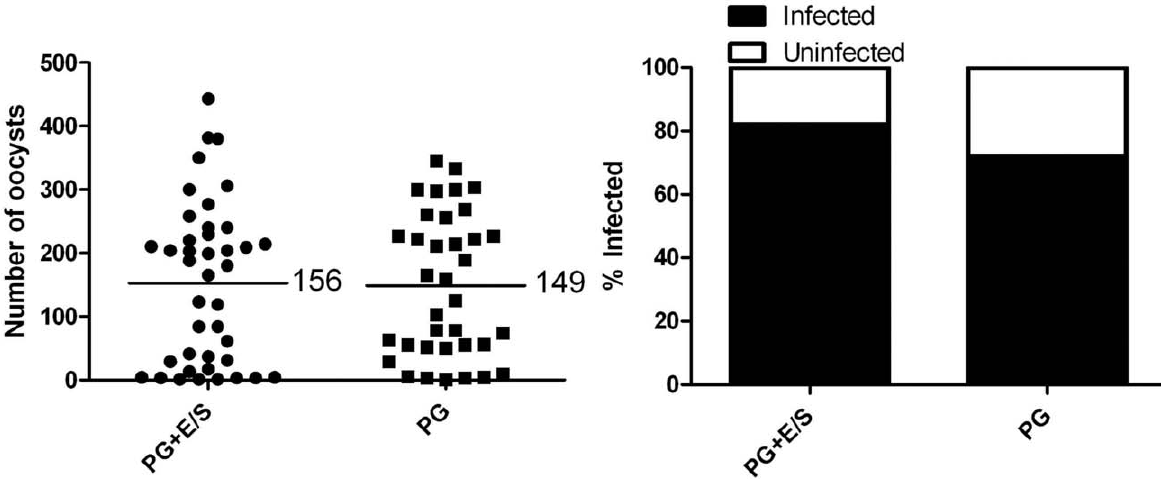
Figure 6. B.malayi E/S products have no effect on Plasmodium infection. Plasmodium infection intensity and prevalence in Ar. subalbatus exposed to P. gallinaceum- infected blood supplemented with B. malayi E/S products. Mosquitoes that fed on blood containing P. gallinaceum alone served as controls. Points indicate the absolute value of oocyst counts in individual mosquitoes, and horizontal black bars represent the mean intensity. There was no significant difference in Plasmodium development between mosquitoes that were exposed to P. gallinaceum alone (n=50) or mosquitoes exposed to a bloodmeal that contained P. gallinaceum supplemented with B. malayi E/S products (n=50). The left panel indicates infection intensity where points indicate the absolute value of oocyst counts in individual mosquitoes, and horizontal black bars represent the mean intensity. The right panel indicates prevalence of infection where the bars represent the total population of mosquitoes examined. The filled portion of the bars indicates the proportion of mosquito midguts that were positive for at least one oocyst; the unfilled portion of the bar indicates the proportion of midguts that were uninfected. PG, P. gallinaceum ; E/S, B. malayi excretory/secretory products.